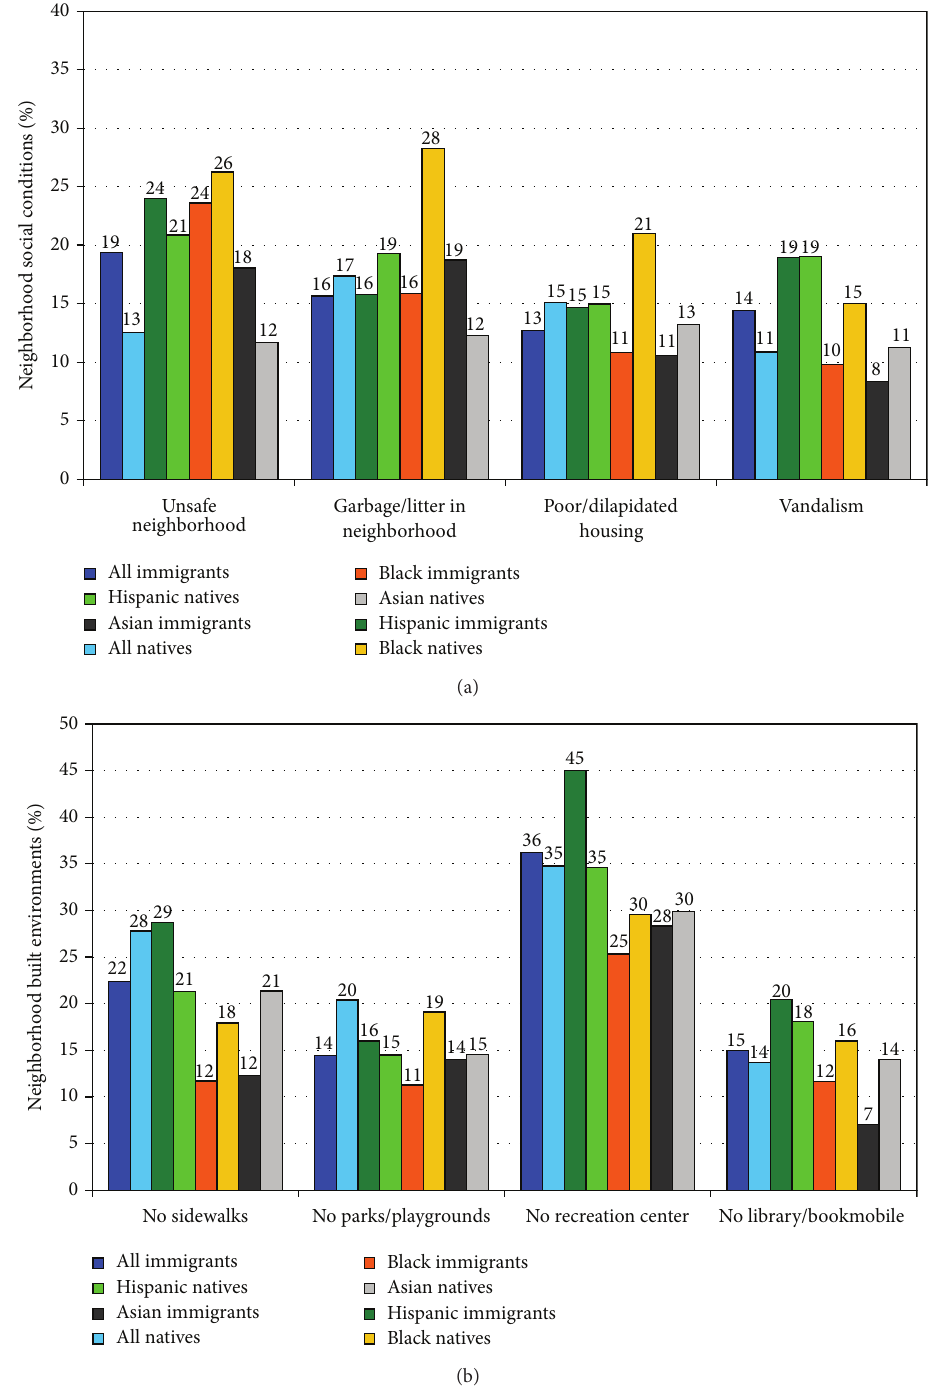
Figure 7: Neighborhood environments for immigrant and native-born children, United States, 2007. Source: The 2007 National Survey of Children’s Health ( 𝑁 = 91, 642 ) Immigrant children: children of immigrant parents; native-born children: children of US-born